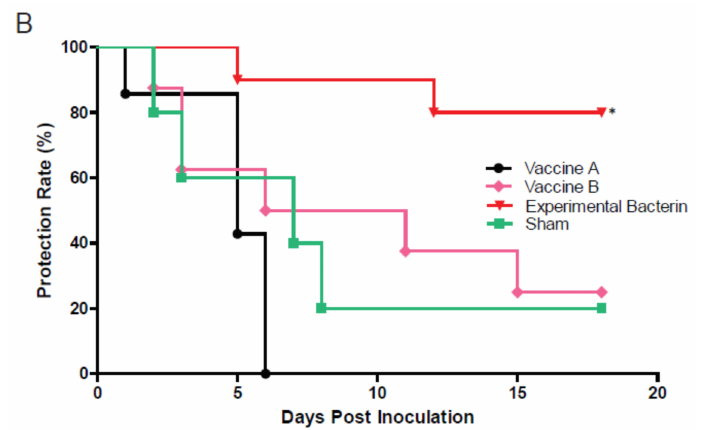
Figure 4. The e ffi cacy of di ff erent vaccines in protecting sheep from C. jejuni clone SA-induced abortion. ( A ) Campylobacter -culture-positive rate in postmortem samples (ewe heart blood, utero-placenta, and fetal lung and liver tissue) at necropsy. ( B ) Protection rate induced by various vaccines during an 18 day observation period post challenge. The protection e ffi cacy of the experimental bacterin vaccine is significantly di ff erent from the sham control (indicated by an asterisk; log-rank (Mantel–Cox) test; p <